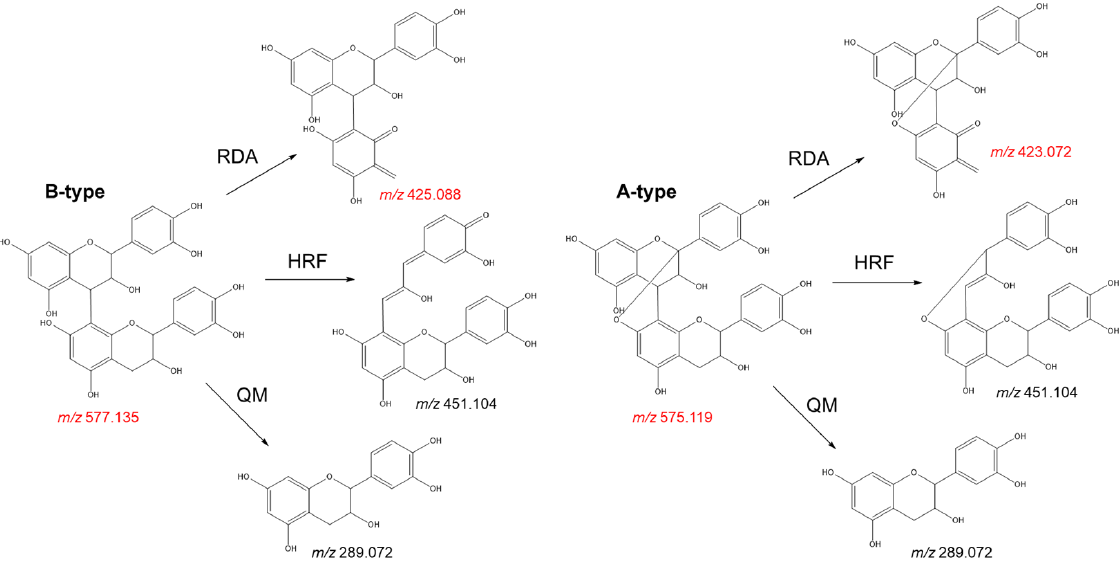
Figure 8. Fragmentation pattern of A-type and B-type procyanidin dimers showing the product ions formed by quinone methide (QM), heterocyclic ring fission (HRF), and Retro-Diels Alder (RDA) fragmentation. Key ions highlighted in red.